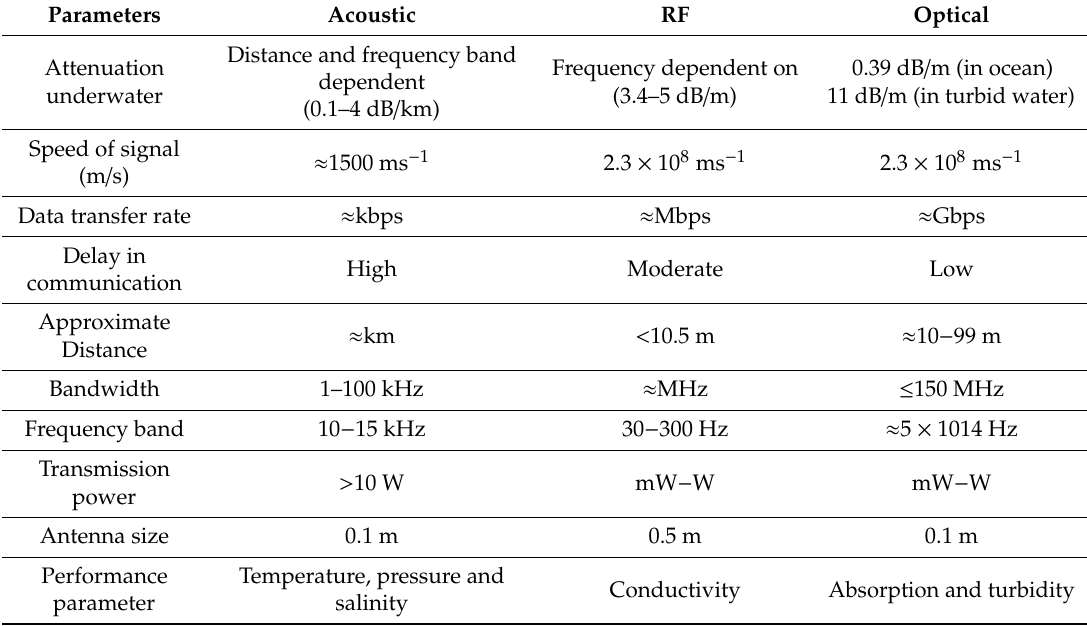
Table 1. Comparison of di ff erent communication technologies in underwater.